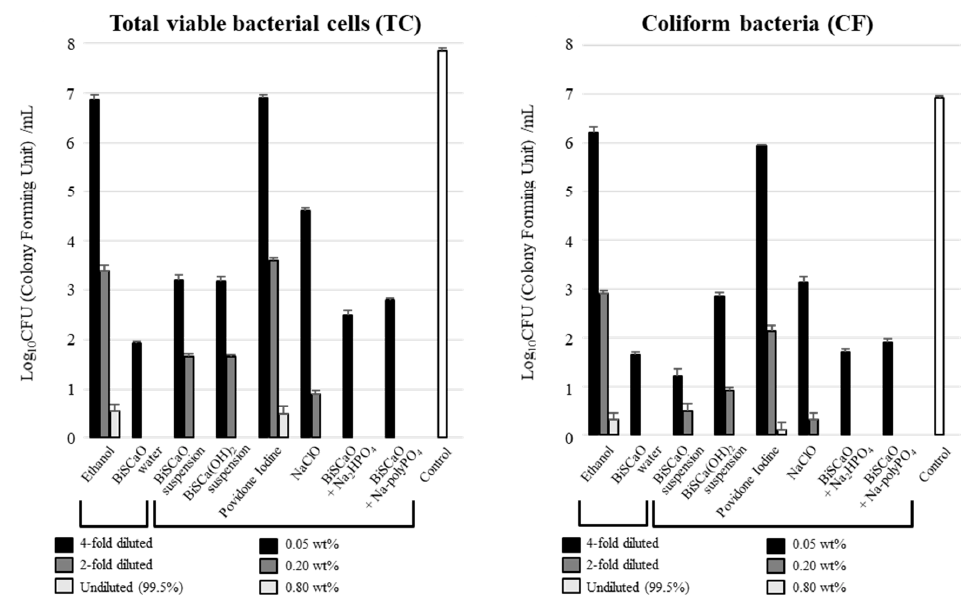
Figure 3. Bactericidal activity of disinfectants against a contaminated suspension comprising normal bacterial flora. Total viable bacterial cells (TC) (left) and coliform bacteria (CF) (right) released from the contaminated suspension in each sample were measured as CFU/mL. BiSCaO Water, dispersion, and colloidal dispersion had high microbicidal activities. Plating and counting were performed as a set of 4 technical replicates (n = 4). Molecules 2020 , 25 , 3001